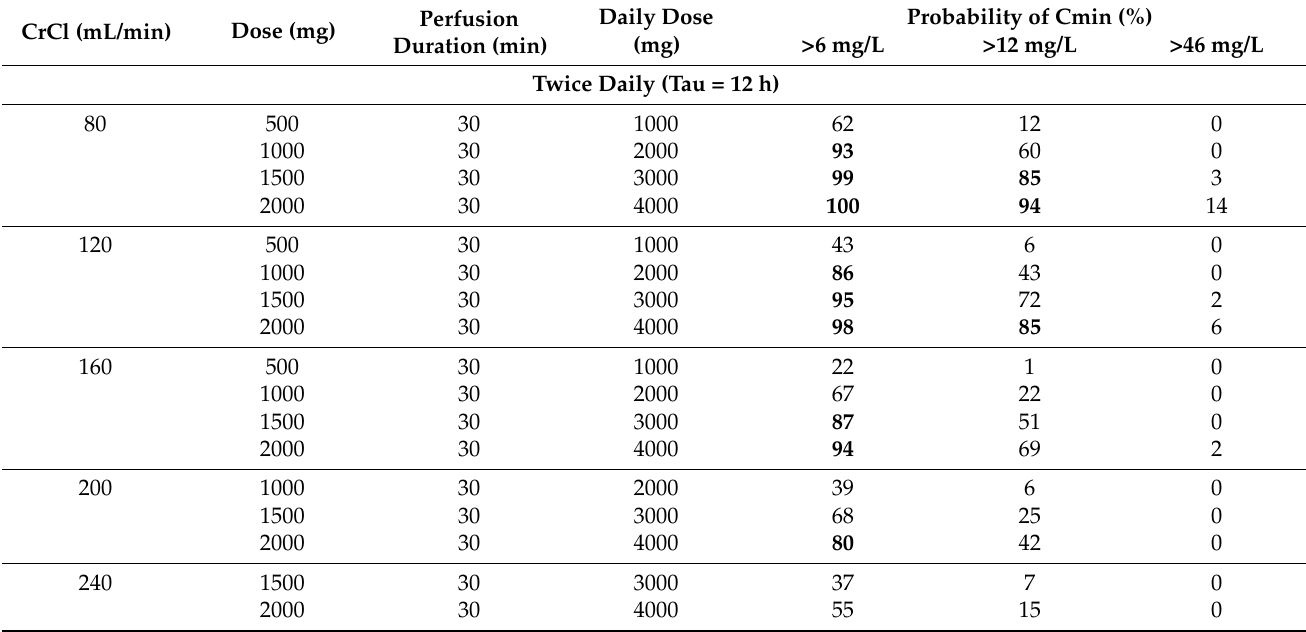
Cmin, Minimum levetiracetam concentration; CrCl, creatinine clearance; Tau, dosing